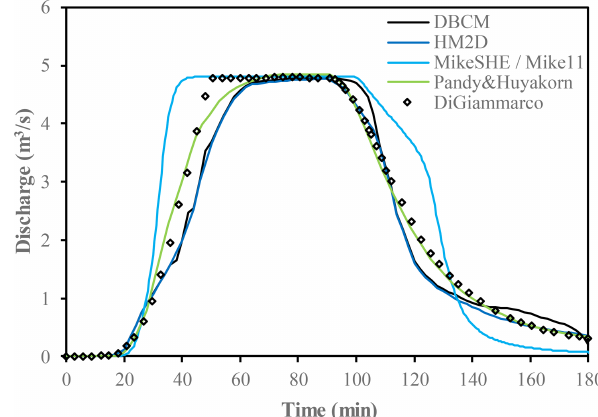
Figure 11. Comparison of discharge hydrographs of the V-shaped